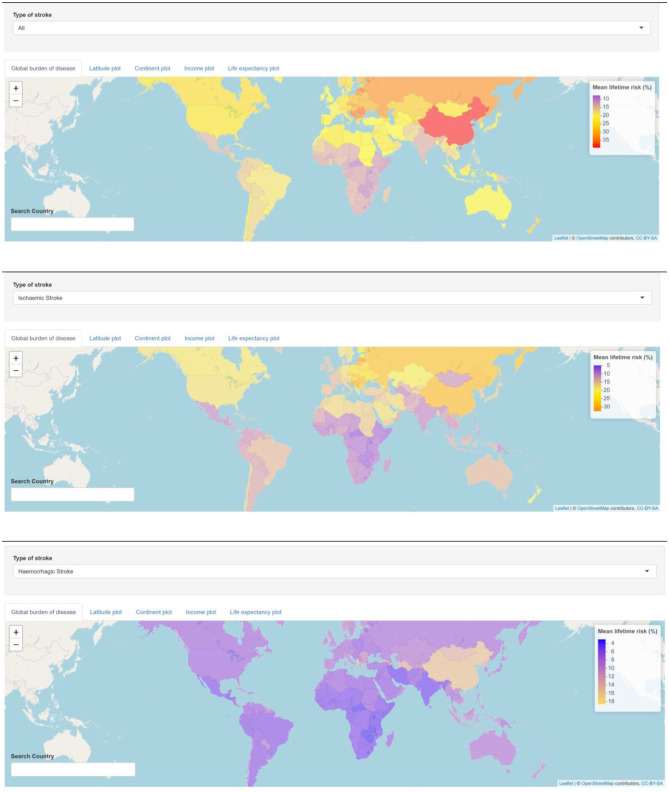
Global reach of stroke. Choropleth (thematic) map illustrating lifetime risk of all stroke (top), ischemic stroke (middle), and hemorrhagic stroke (bottom). Red illustrates a high lifetime risk of stroke, and blue, a low lifetime risk. The user can choose any of these maps by clicking the drop-down icon. The map can be accessed at https: //gntem3.shinyapps.io/strokeglobal/.